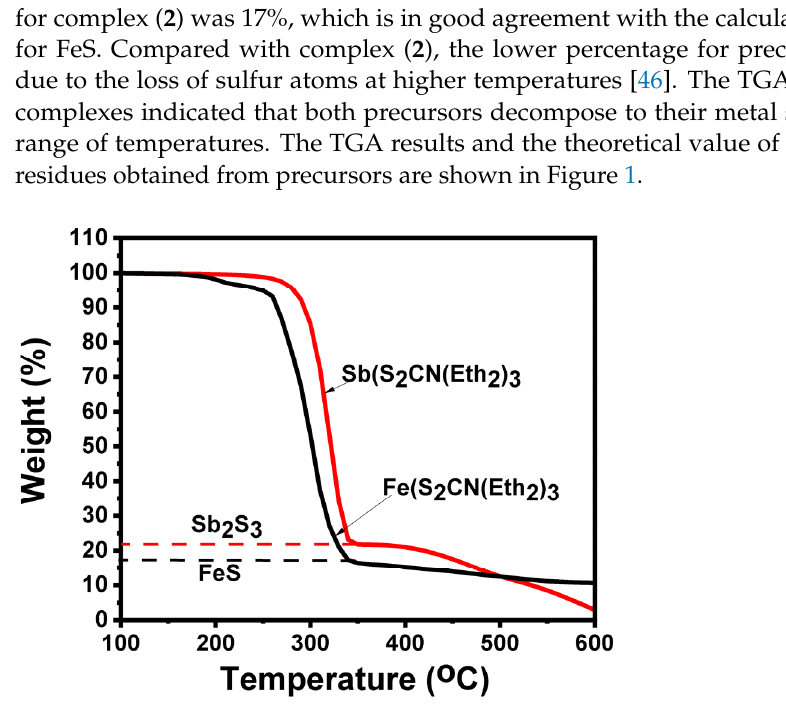
Figure 1. Thermogravimetric analysis (TGA) of Sb[S 2 CNEt 2 ] 3 and Fe[S 2 CNEt 2 ] 3 complexes. The black dotted line refers to the weight loss for the formation of Sb 2 S 3 and the red dotted line refers to the values of weight loss to produce FeS.